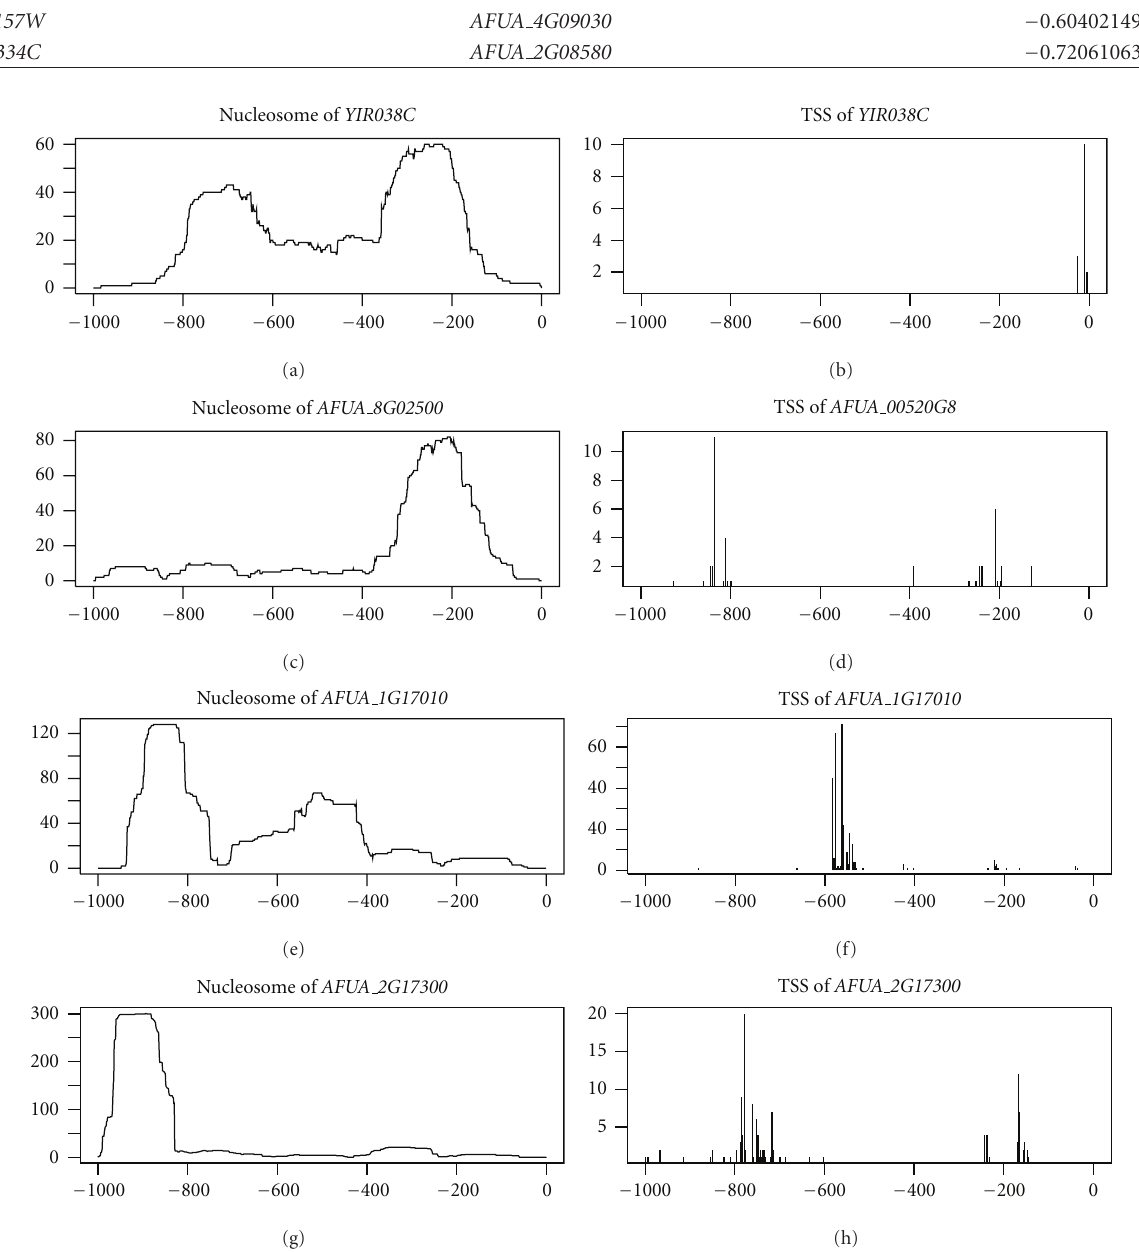
Figure 3: Mapping numbers of nucleosomes and transcription start sites in the promoter regions of YIR038C , AFUA 8G02500 , AFUA 1G17010 , and AFUA 2G17300 . Position 0 indicates the translational start site. Single-gene duplications and gene cluster duplications AFUA 1G00470 and AFUA 8G04080 and in the gene body consisting of multiple genes were identified. One cluster of 4 between AFUA 1G00440 and AFUA 8G04110 (Spearman’s rank correlation coe ffi cients were 0.43 and 0.23, resp.) genes ( AFUA 1G00420 to AFUA 1G00470 ) is a duplication of another 4-gene cluster ( AFUA 8G04120 to AFUA 8G04080 ) (Table 2). With the exception of these 2 cases, the nucle- (Table 2). Among these gene pairs, the nucleosome position osome position profile was highly conserved (correlation profile was poorly conserved in the gene promoter between coe ffi cients were higher than 0.7) (Table